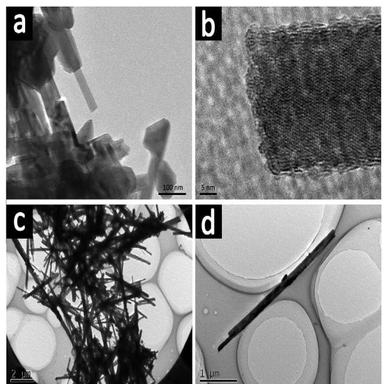
(a) TEM image and (b) HRTEM image of Li1.2Ni0.15Co0.1Mn0.55O2 CLNs. (c, d) TEM images of Li1.2Ni0.15Co0.1Mn0.55O2 AMs.